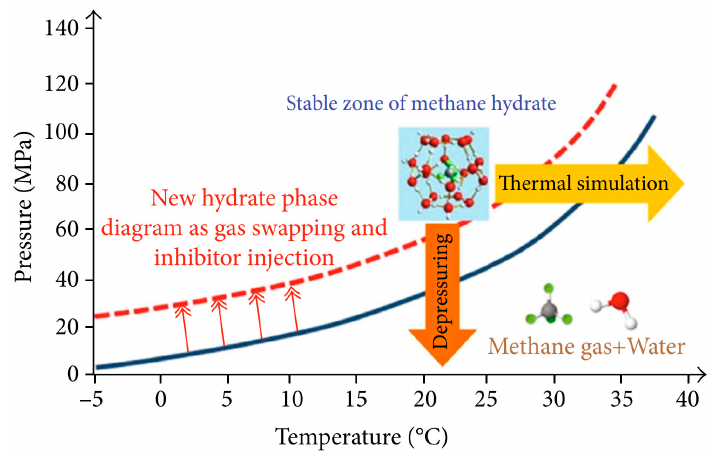
Figure 2. Hydrate dissociation in P-T diagram